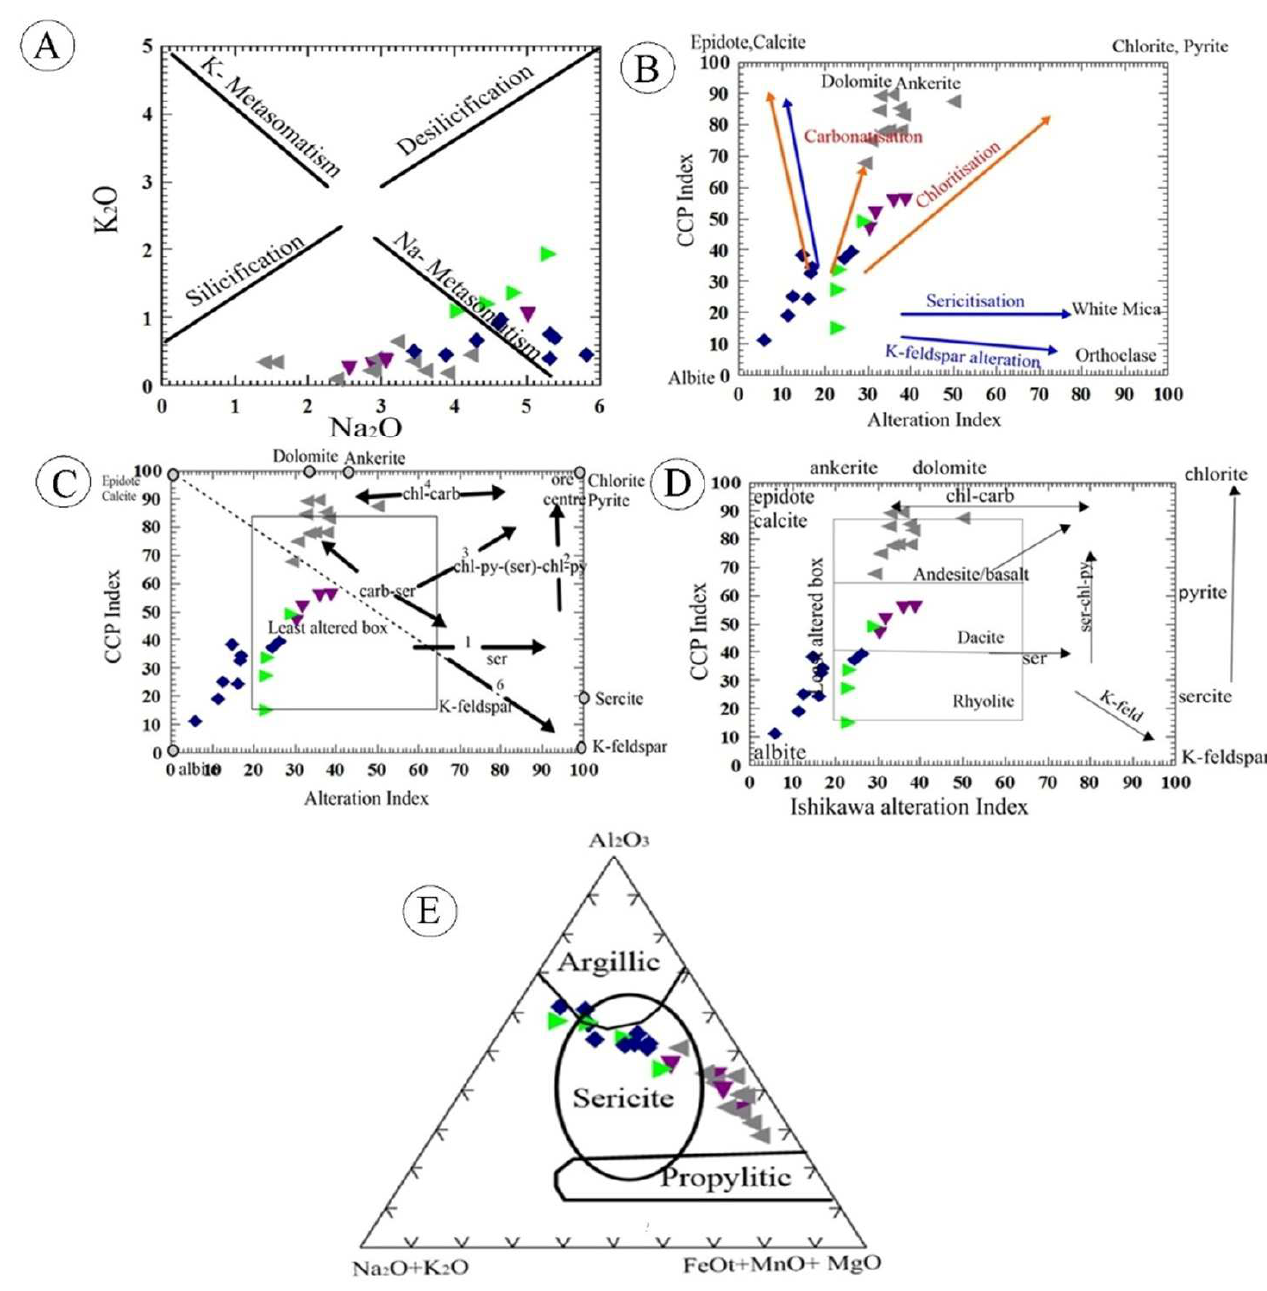
Figure 7. Different alteration diagrams; ( A ) Na–K binary diagram of [59]. ( B ) Chlorite–Carbonate– Pyrite Index [60] versus Alteration Index [61] of intrusive rocks of Abu Ghalaga on the “alteration box plot”. ( C ) CCPI versus AI for least-altered and altered samples [60]. ( D ) CCP Index [60] versus Ishikawa Alteration Index (AI) (Ishikawa et al., 1976); (AI) = 100(K 2 O + MgO)/(K 2 O + MgO + Na 2 O + CaO); CCPI = 100(MgO + FeOT)/(MgO + FeOT + Na 2 O + K 2 O). ( E ) Al 2 O 3 − (Na 2 O + K 2 O) − (FeOT + MnO + MgO) ternary diagram of [62].